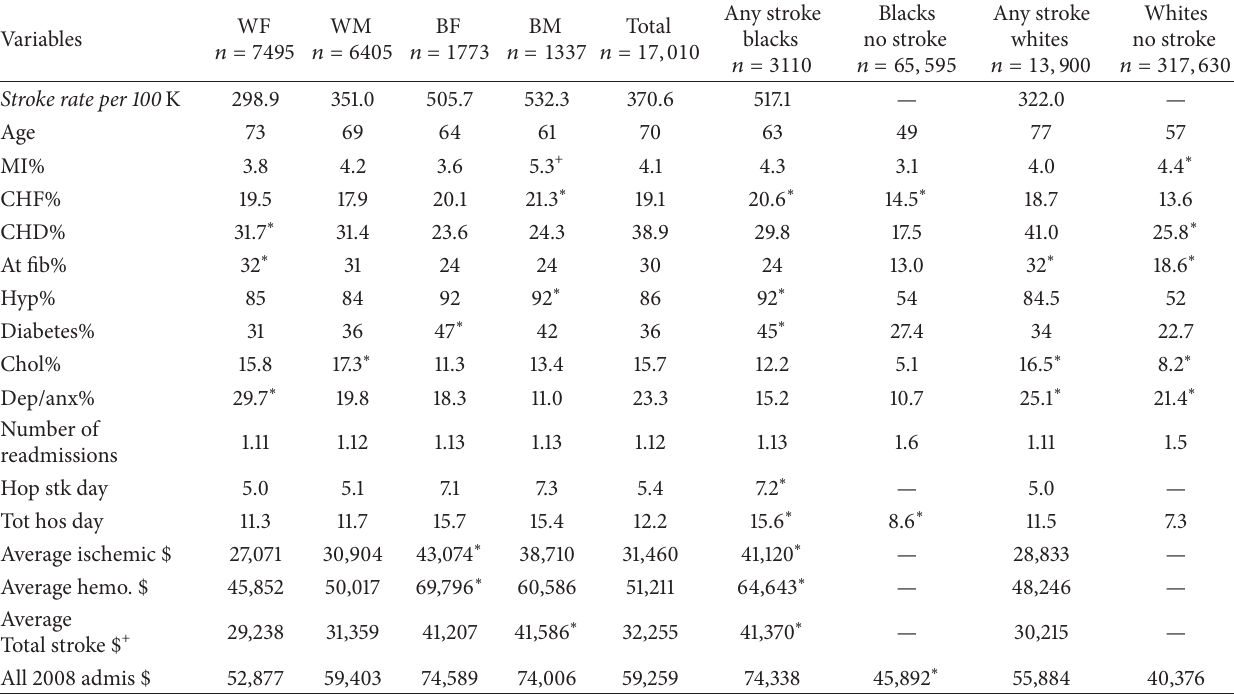
Table 1: Age-adjusted stroke rates and characteristics by race and gender in 2008 ( 𝑛 = 17, 010